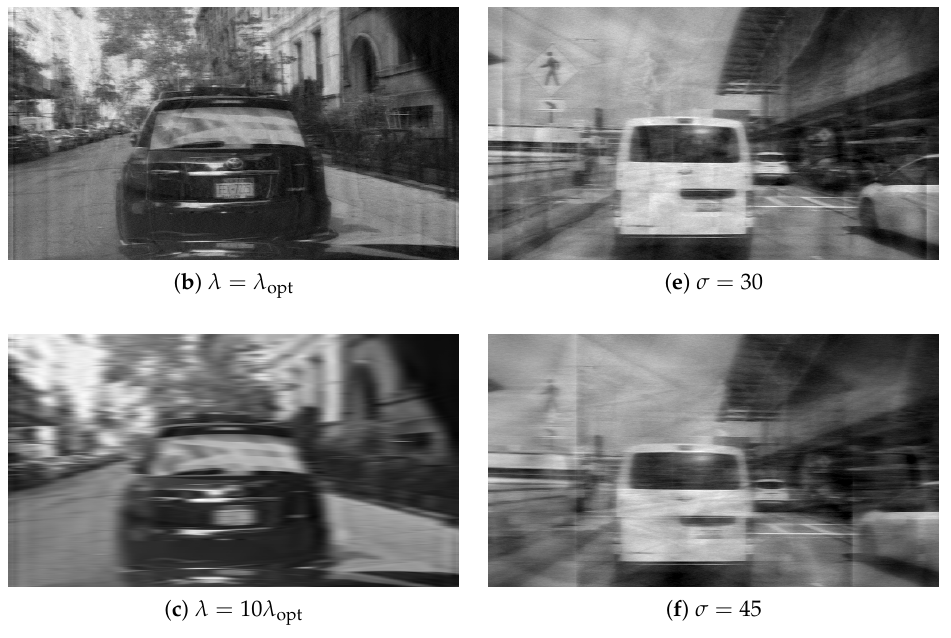
Figure 2. Deconvolved images: ( a – c ) single blur kernel, different λ values; ( d – f ) different blur kernels, λ = λ opt for each